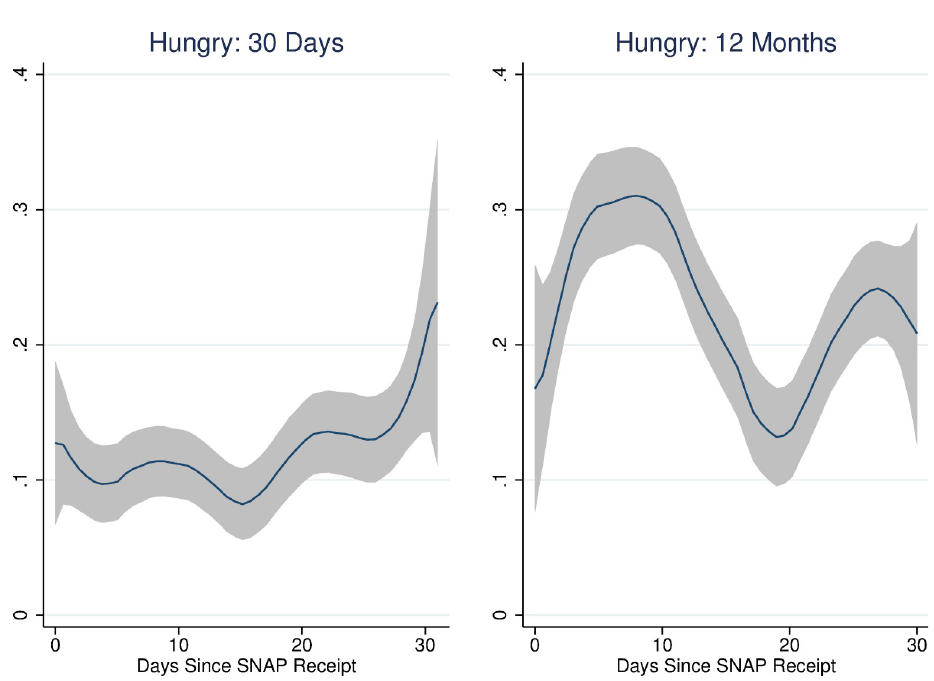
Fig 6. Individual 30-day and household 12-month responses to hungry FSM item and days since SNAP. Source: Authors’ calculations using NHANES data. N = 2,216. Non-parametric regression estimates are weighted.